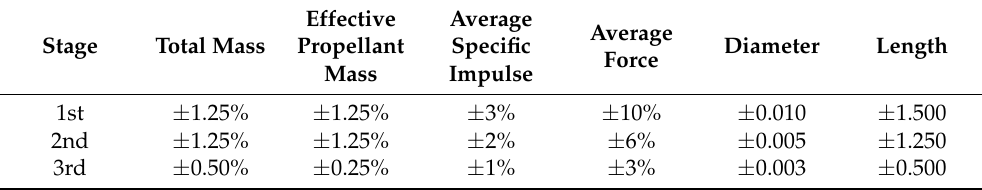
Table 4. Parameter deviation limits of the LV